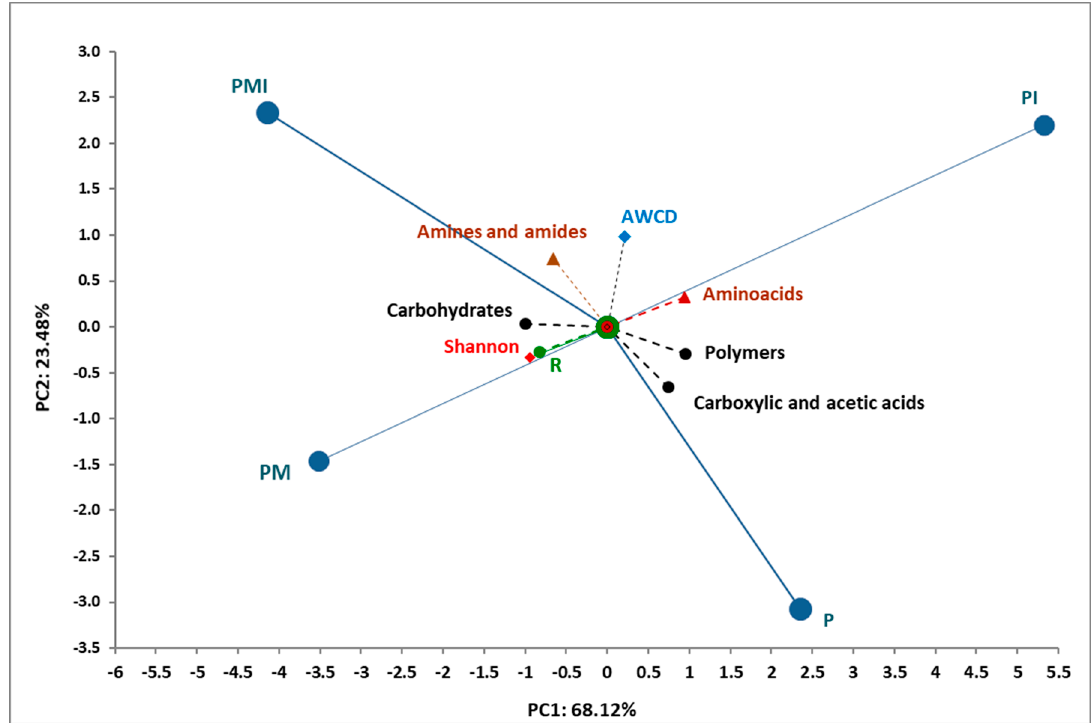
Figure 6. Principal component analysis of the microbial parameters, biodiversity indices, and Biolog EcoPlates data from soil samples incubated for 120 h.